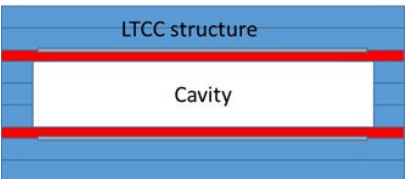
Figure 2. The cross-section (not to scale) of the cavity with the protective LTCC layers, which is presented in red. Note that the thickness of the protective layer is 50 μ m or 100 μ m. The volume of the cavity remains the same in both cases.